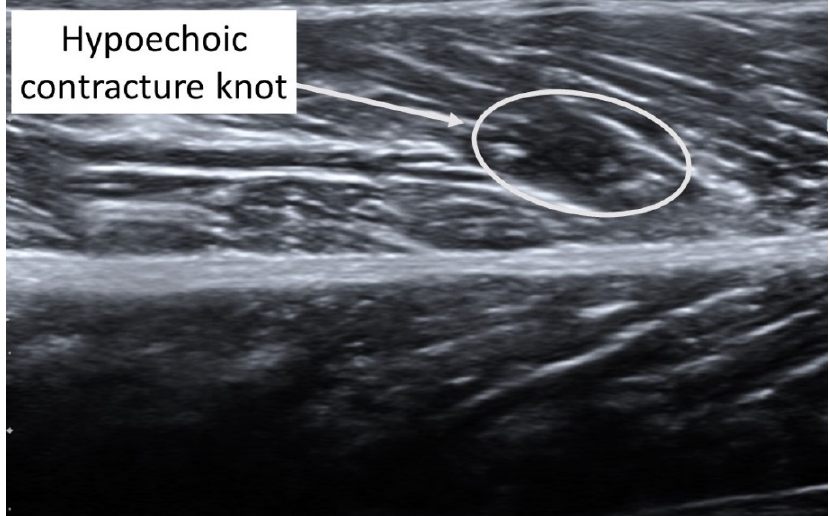
Figure 1. Ultrasound imaging assessment of the right gastrocnemius muscle showing the palpable contracture knot as a hypoechoic (hyperperfused) area.